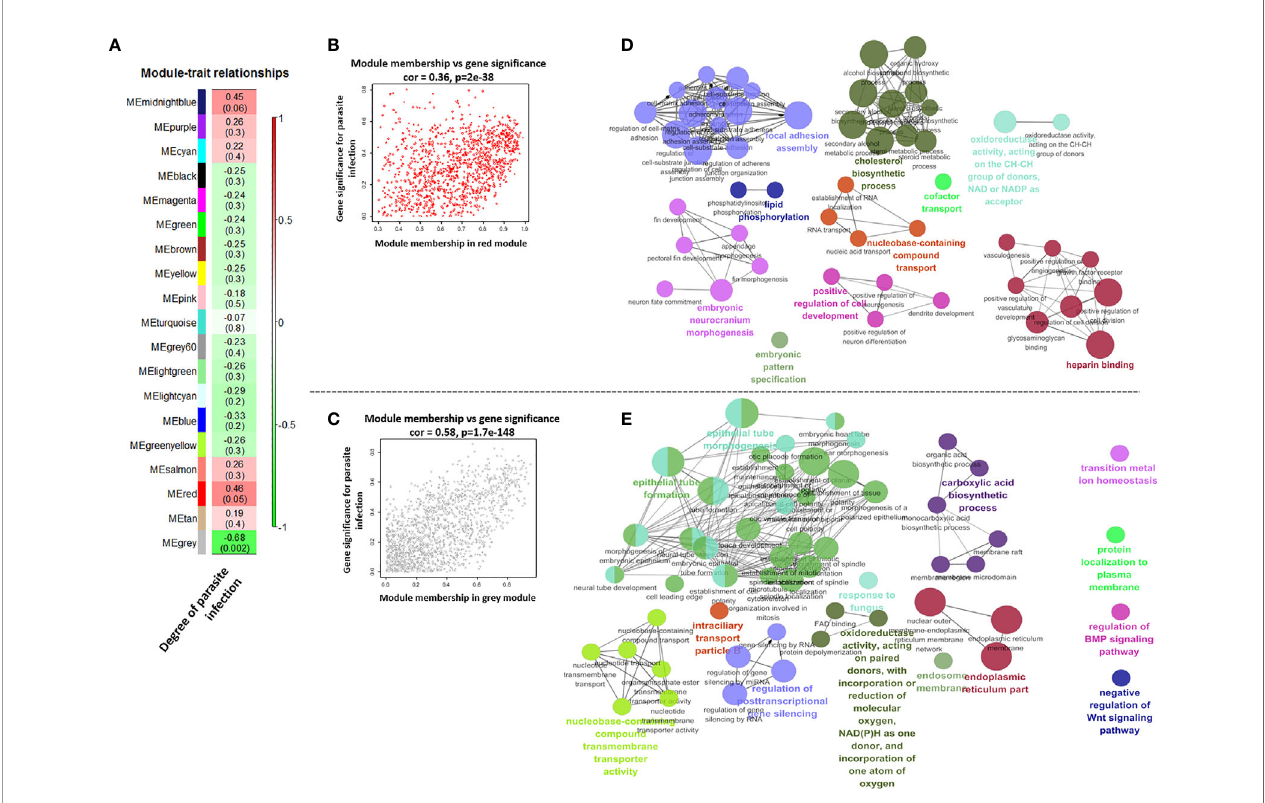
FIGURE 6 | Correlations between each module ’ s eigen-gene (the fi rst principal component among the genes in the module) and degree of parasite infection (A) . Scatter plots for module membership and gene signi fi cance in the red and gray module (B, C) . The size of circles and edge thickness represents the number of enriched genes in individual functional groups and the degree of overlap (biological similarity) between two pathways in the red and gray module, respectively (D, E)